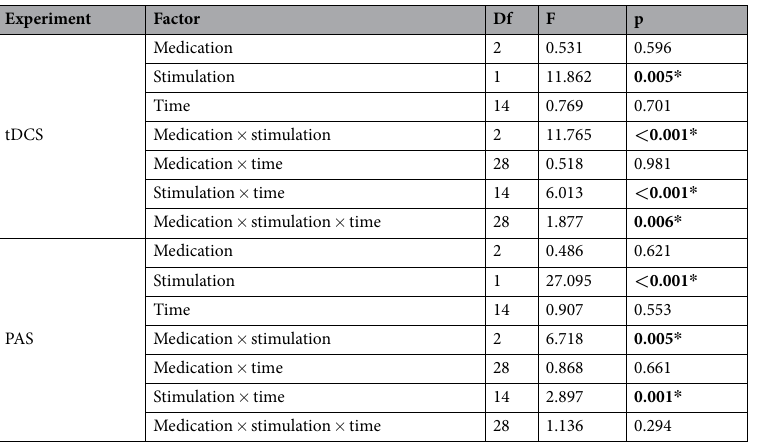
Table 2. Results of the repeated measures ANOVA. * Significant results at p <